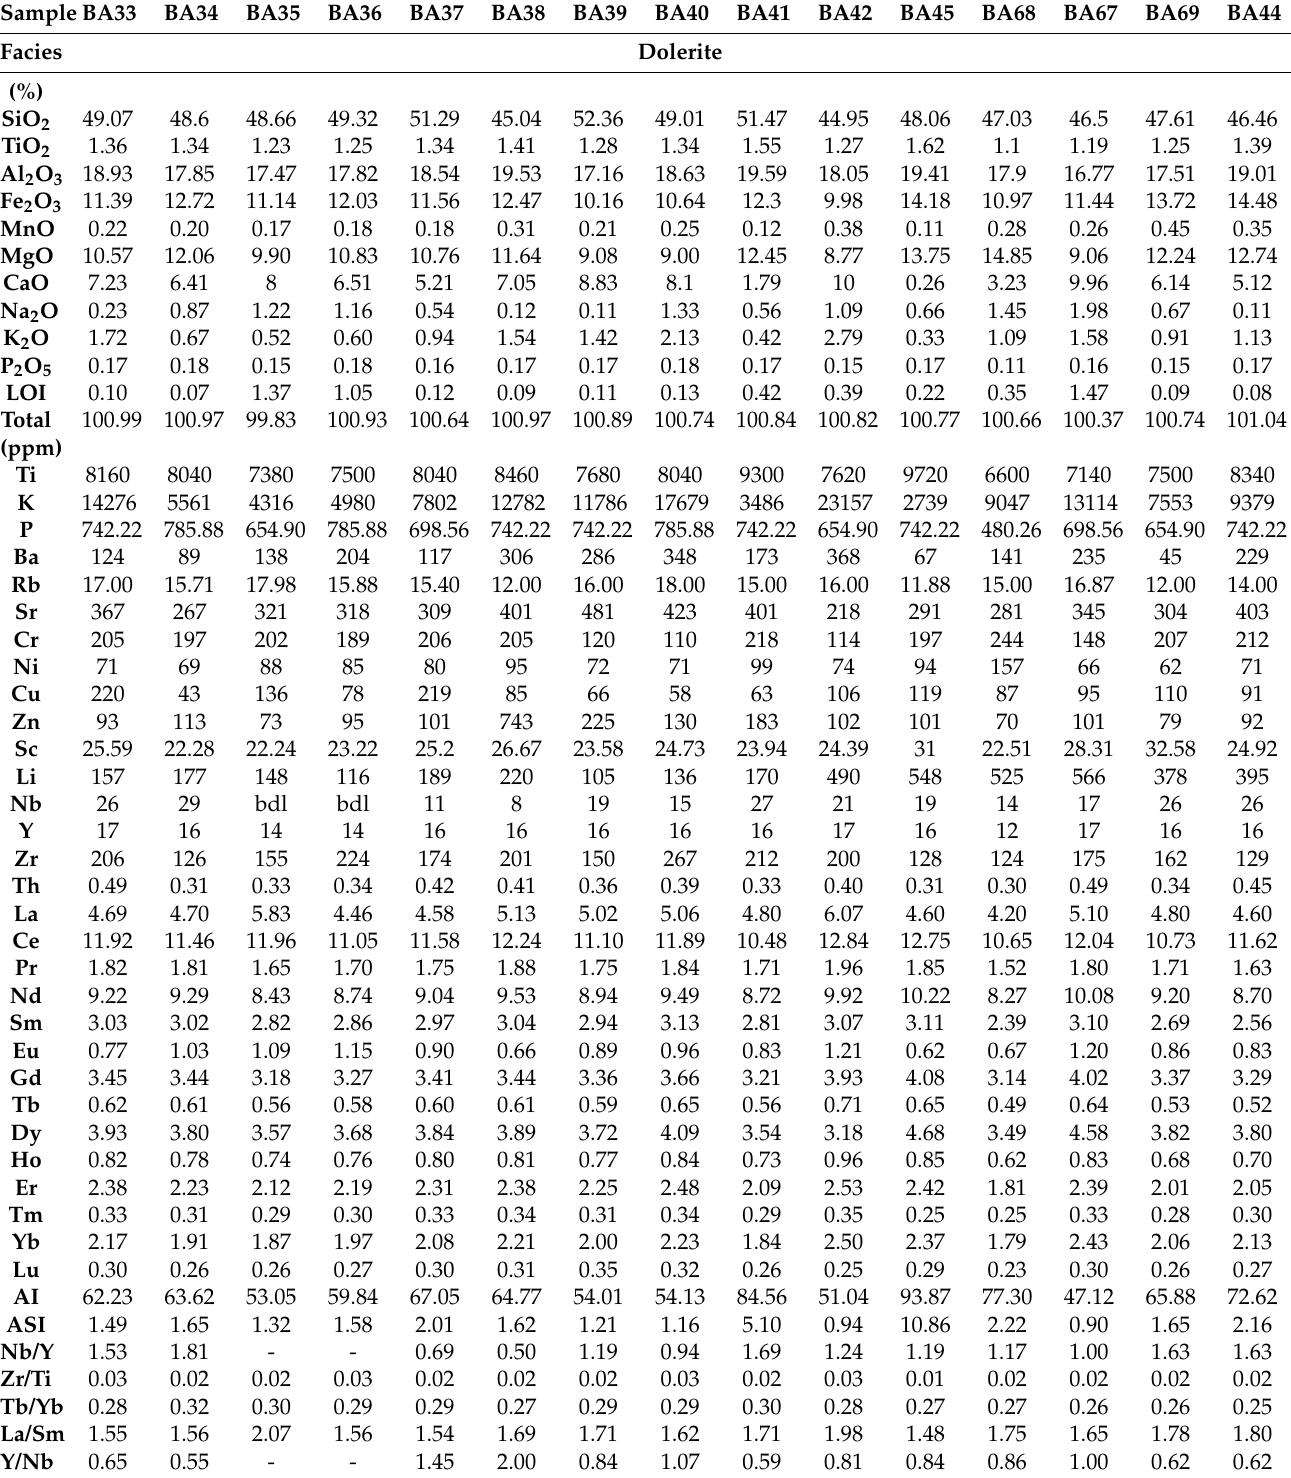
Table 2. Chemical analyses of major, trace and rare earth elements of dolerite dikes in the Upper Carboniferous series of the NNE Achemmach. bdl: below detection